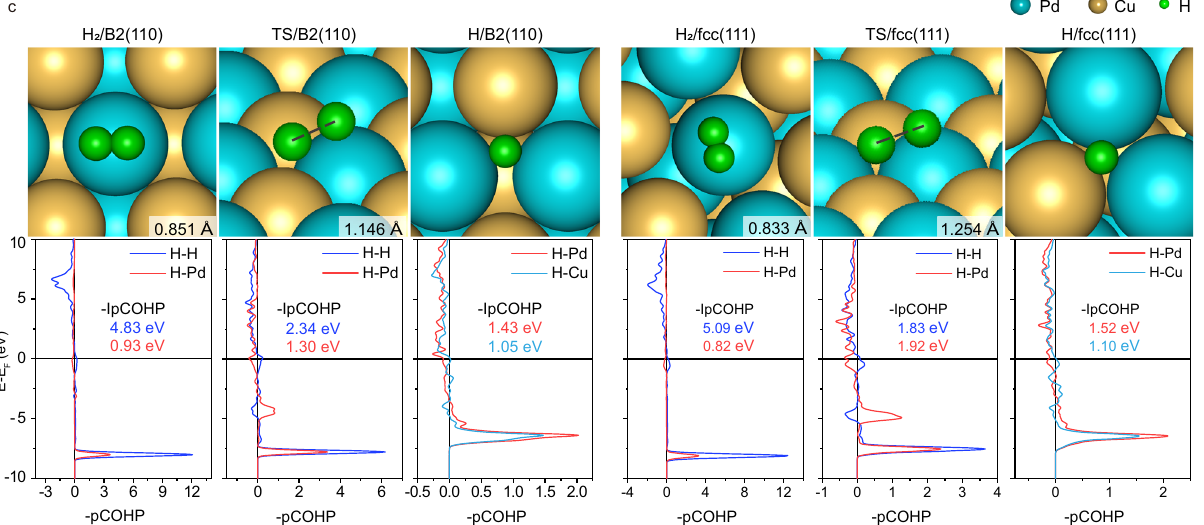
con fi gurations of H 2 and the dissociated H atom and the corresponding COHP curves